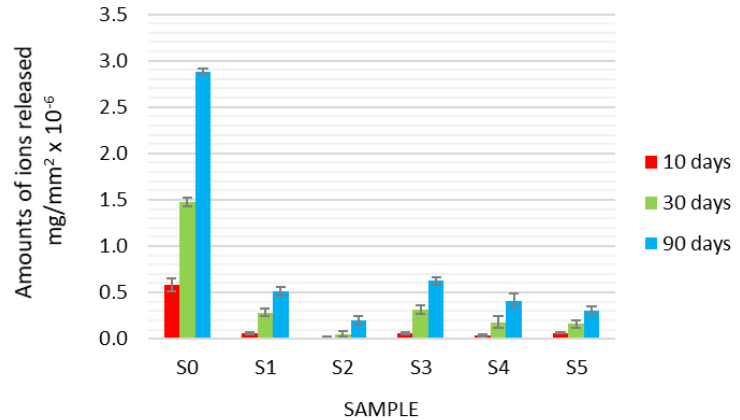
Figure 7. Amounts of Ni ions released into artificial saliva for the particular coatings after 10, 30, and 90 days.